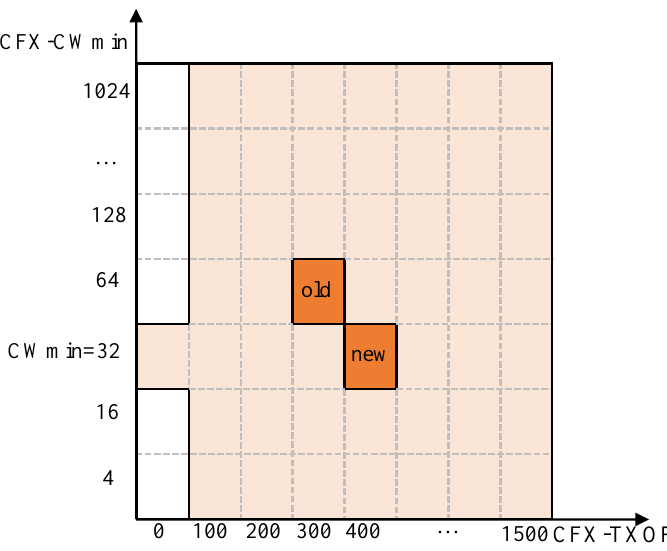
Figure 4. Example of the action space. The agent can move along the dimensions of the CFX-CWmin and CFX-TXOP search spaces. The action ( − 1, 1) at the position marked “old” will move the agent to the position marked “new”, corresponding to a CFX-CWmin of 32 and a CFX-TXOP of 400